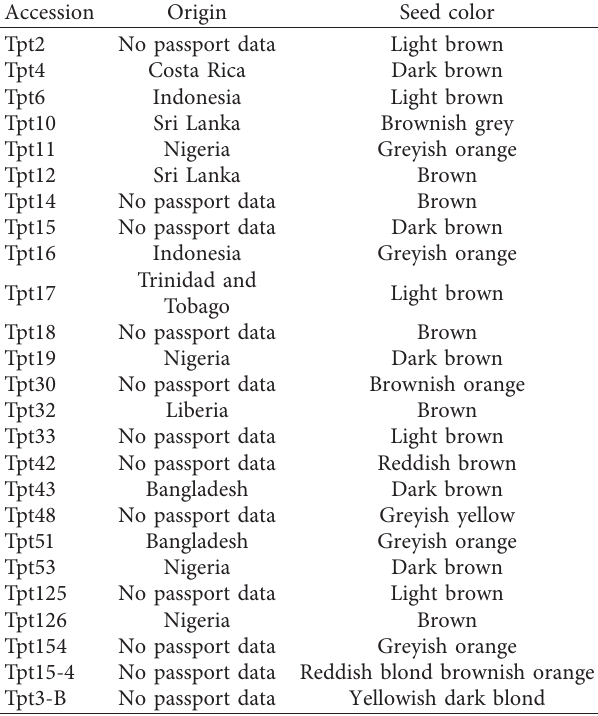
Table 1: Twenty-five accessions of winged bean sourced from